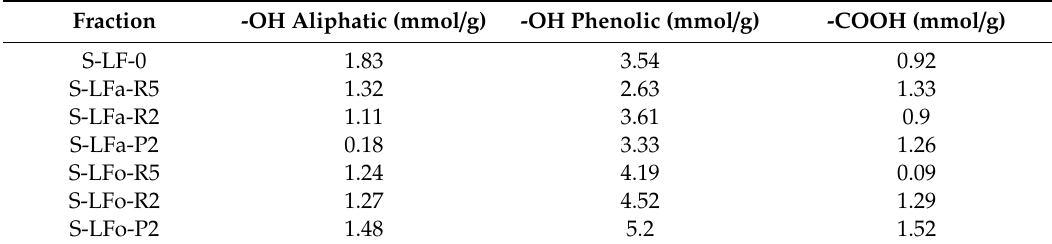
Figure 8. 31 P-NMR spectra of lignin fractions recovered from the aqueous and the organic process applied on S-LF-0. Table 7. Detailed hydroxyl / carboxyl quantification by 31 P-NMR for the fractions recovered from aqueous and organic processes applied on S-LF-0.